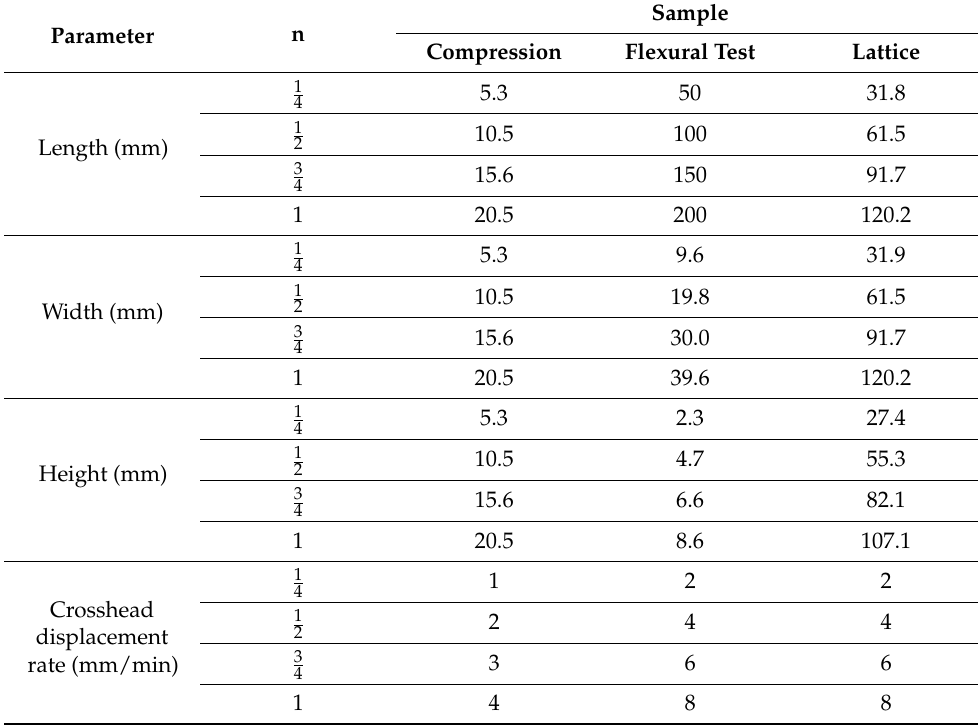
Table 2. Average dimensions and test conditions for the compression, flexural test and lattice samples.